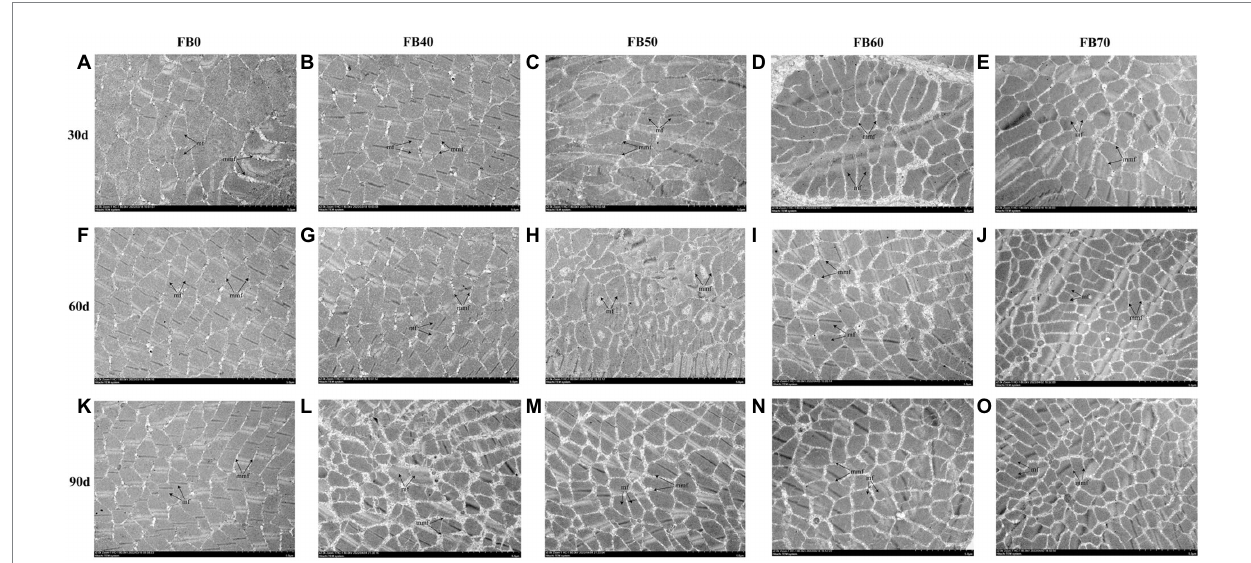
FIGURE 1 Effects of dietary faba bean levels on muscle transverse section microstructure by transmission electron microscope of tilapia Oreochromis niloticus . (A) , Control group on 30 day (D) ; (B) , 40% faba bean group on 30 d; (C) , 50% faba bean group on 30 d; (D) , 60% faba bean group on 30 d; (E) , 70% faba bean group on 30 d; (F) , control group on 60 d; (G) , 40% faba bean group on 60 d; (H) , 50% faba bean group on 60 d; (I) , 60% faba bean group on 60 d; (J) , 70% faba bean group on 60 d; (K) , control group on 90 d; (L) , 40% faba bean group on 90 d; (M) , 50% faba bean group on 90 d; (N) , 60% faba bean group on 90 d; (O) , 70% faba bean group on 90 d. mf, muscle fiber; mmf, matrix between muscle fibers.